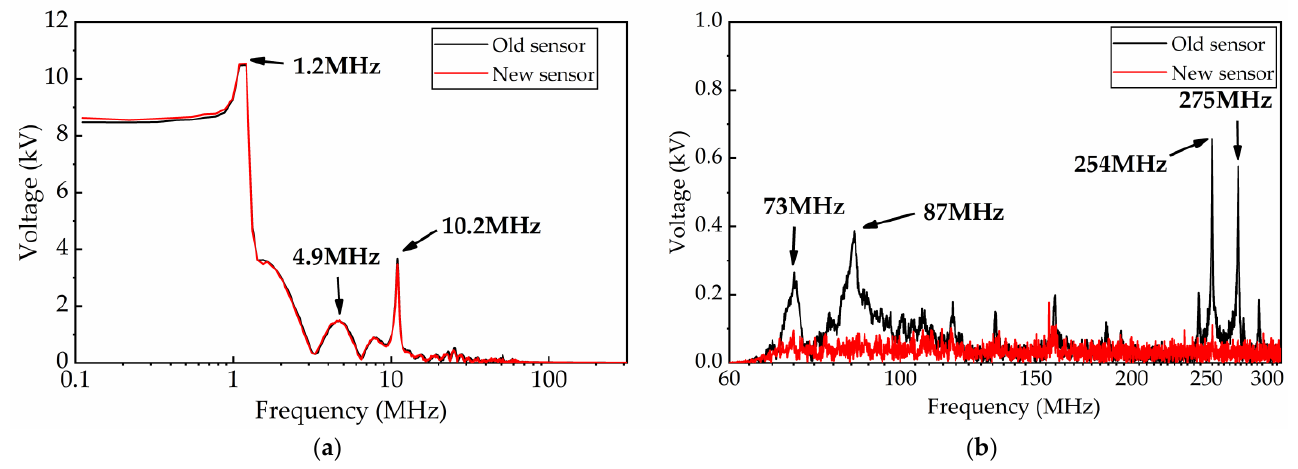
Figure 20. Frequency domain waveform of VFTO. ( a ) Frequency domain waveform with frequency lower than 70 MHz; ( b ) frequency domain waveform with frequency higher than 70 MHz.